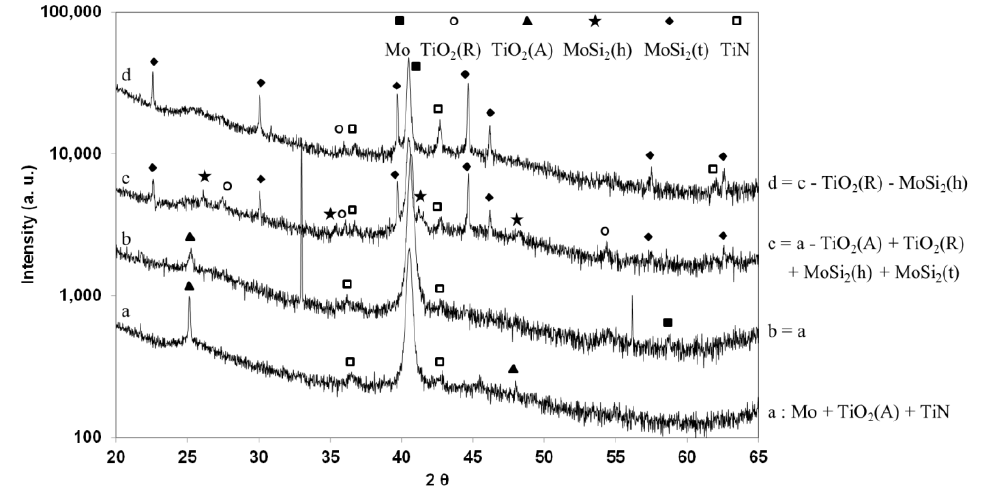
Figure 4. X-ray diffraction patterns of Mo–Ti bilayer films heated at 600 °C and exposed to (Ar-31%N 2 - 6%H 2 ) for 1 h 30 min ( a ), 3 h ( b ), heated at 800 °C and exposed to (Ar-31%N 2 -6%H 2 ) plasma for 1 h 30 min ( c ) and 3 h ( d ).